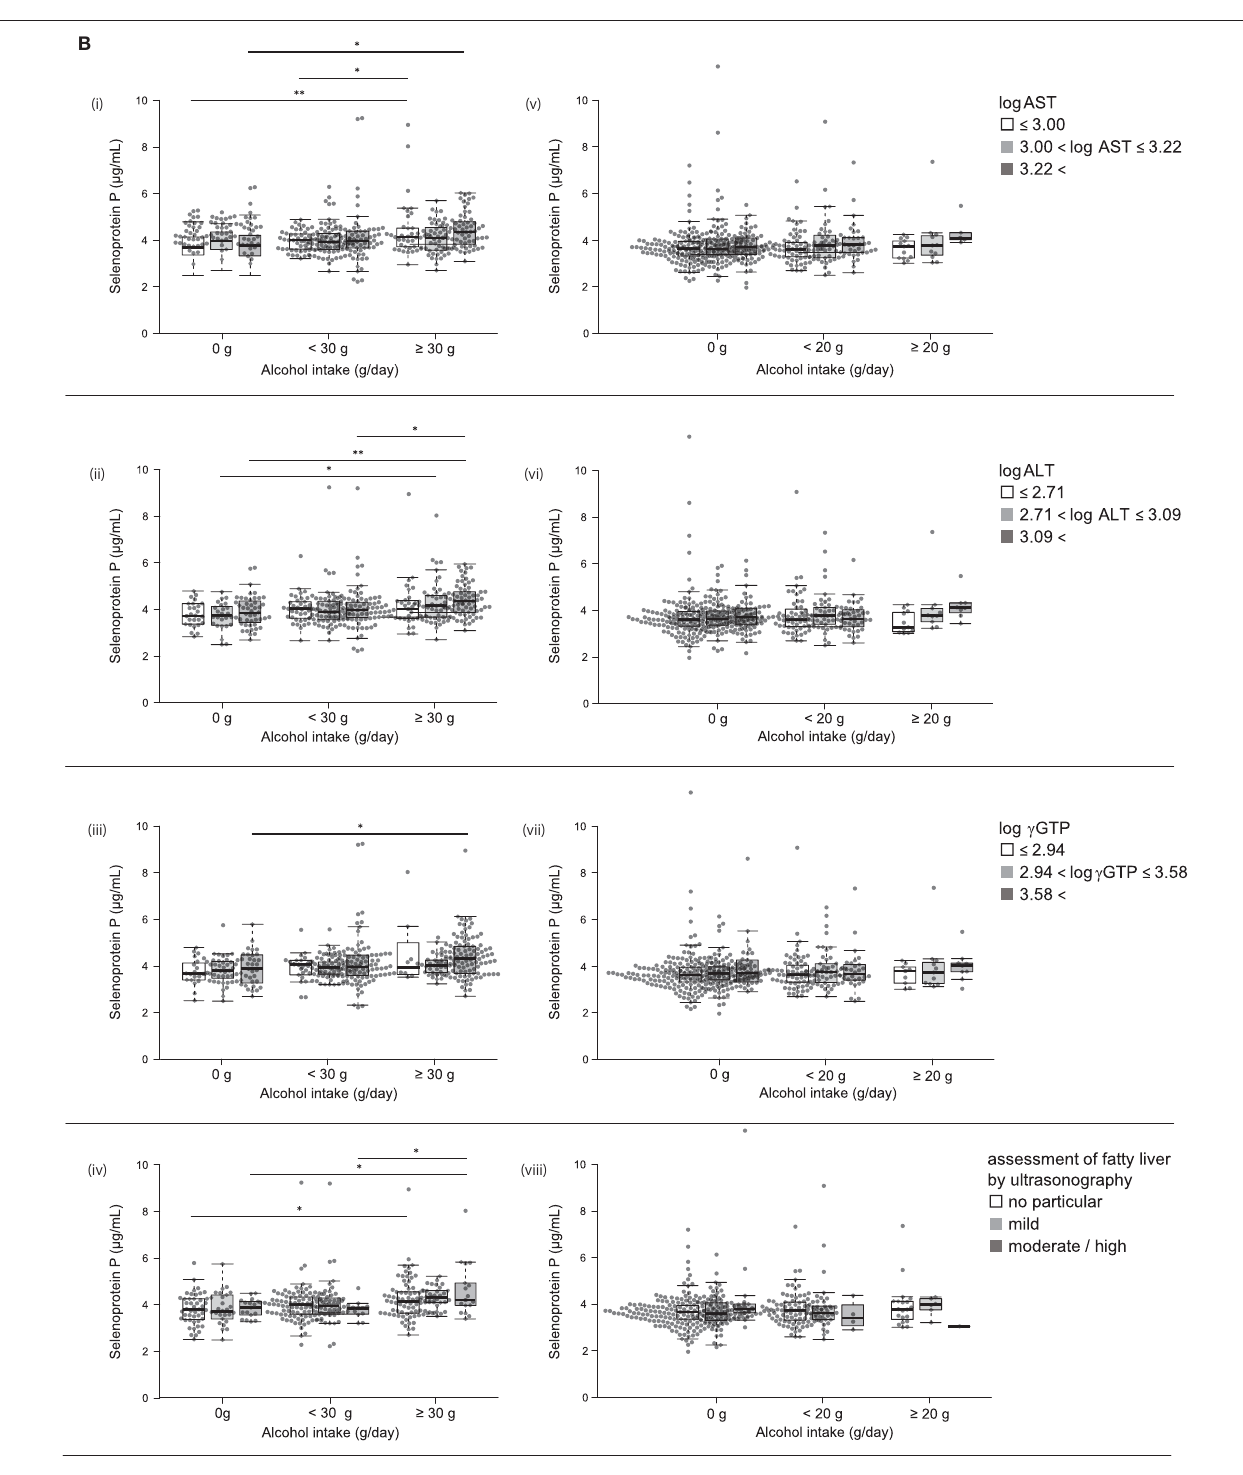
Frontiers in Nutrition |